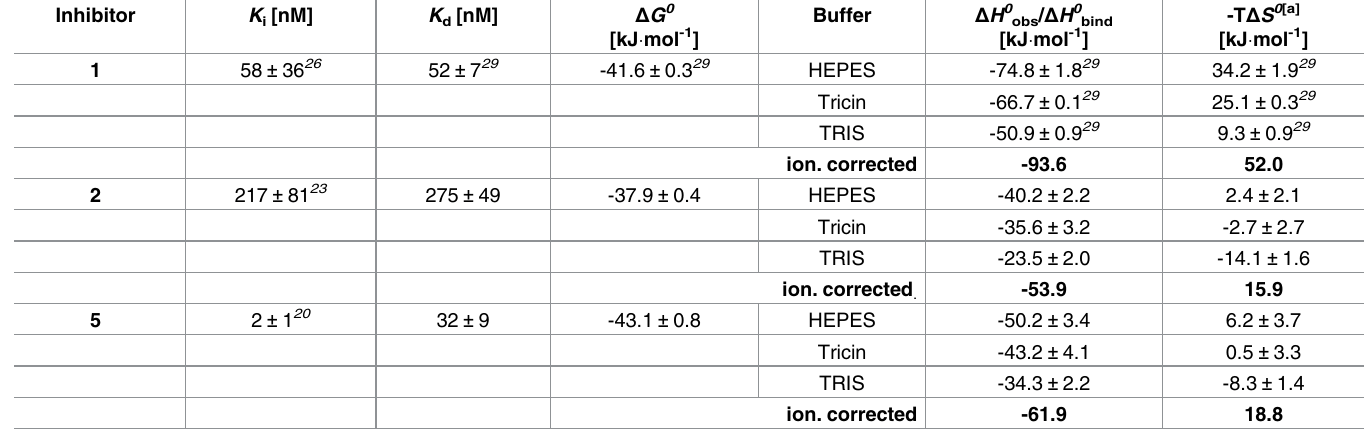
Table 2. Inhibition constants and thermodynamic data at the applied